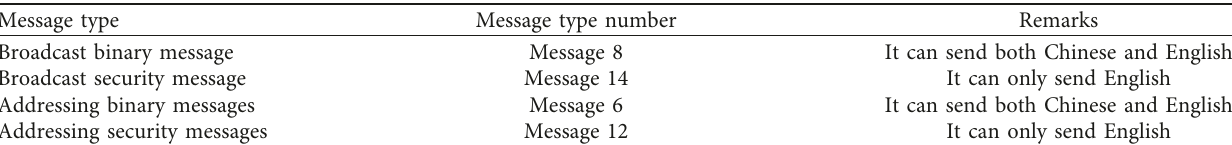
Figure 3: Data acquisition/encoding and decoding process. Table 2: Short message